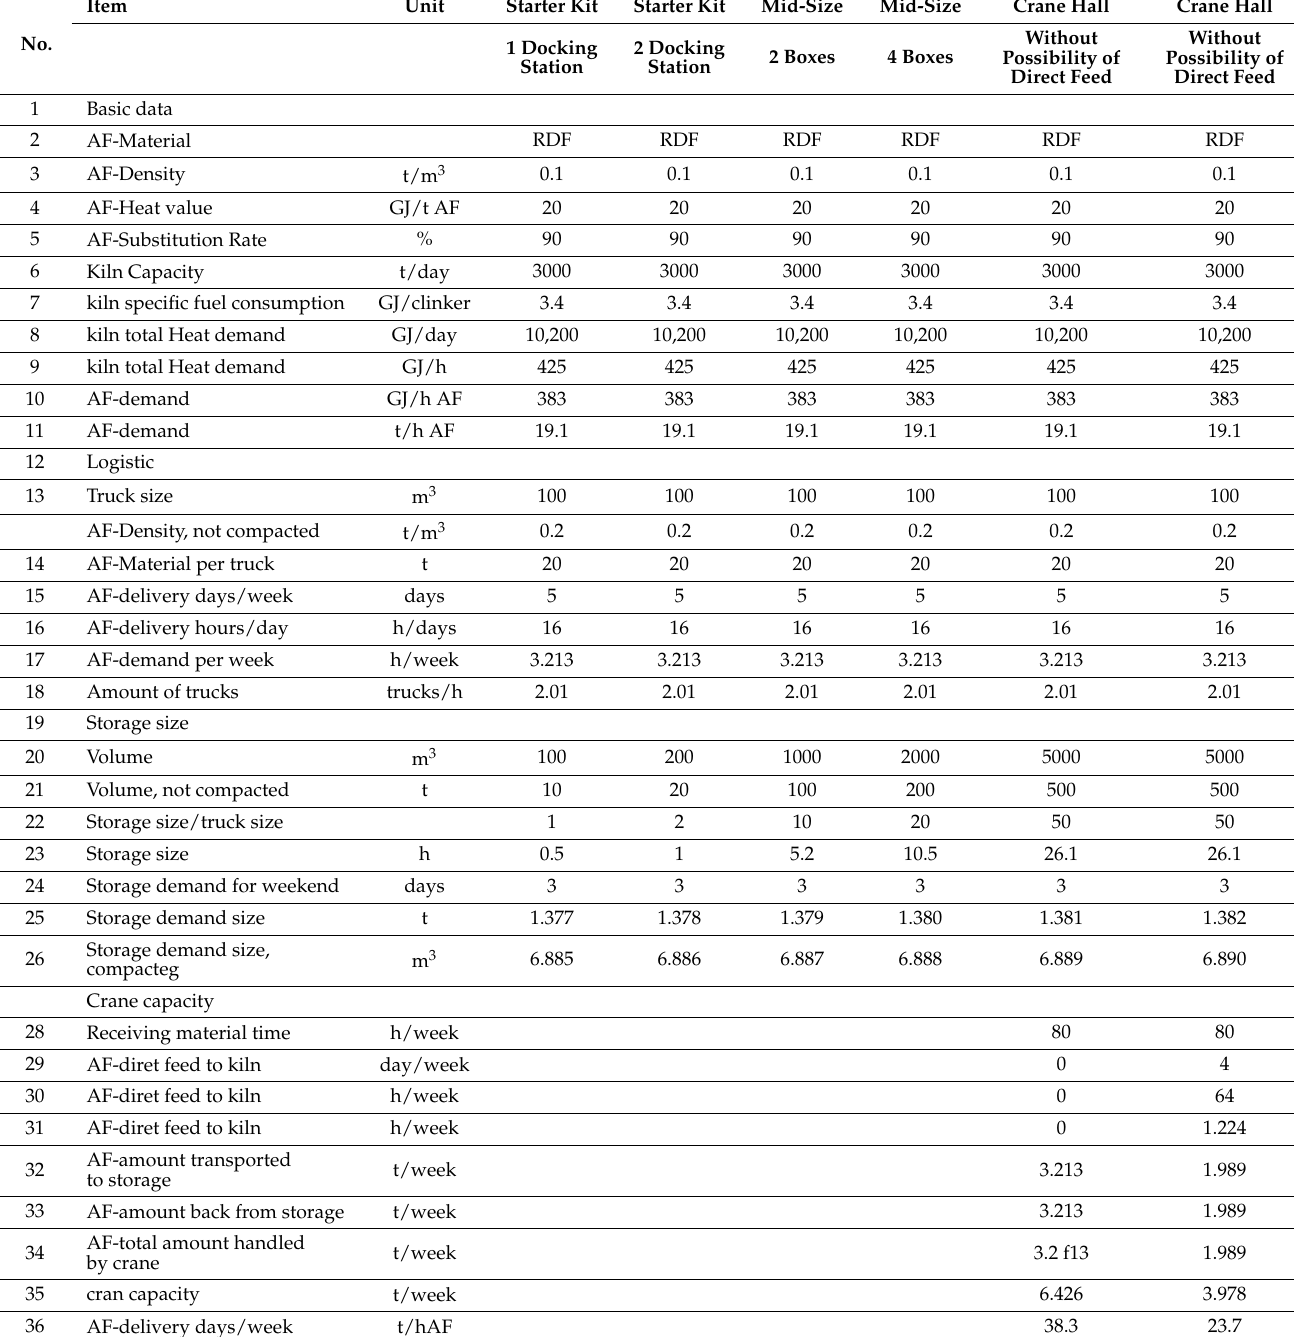
Table 1. RDF storage